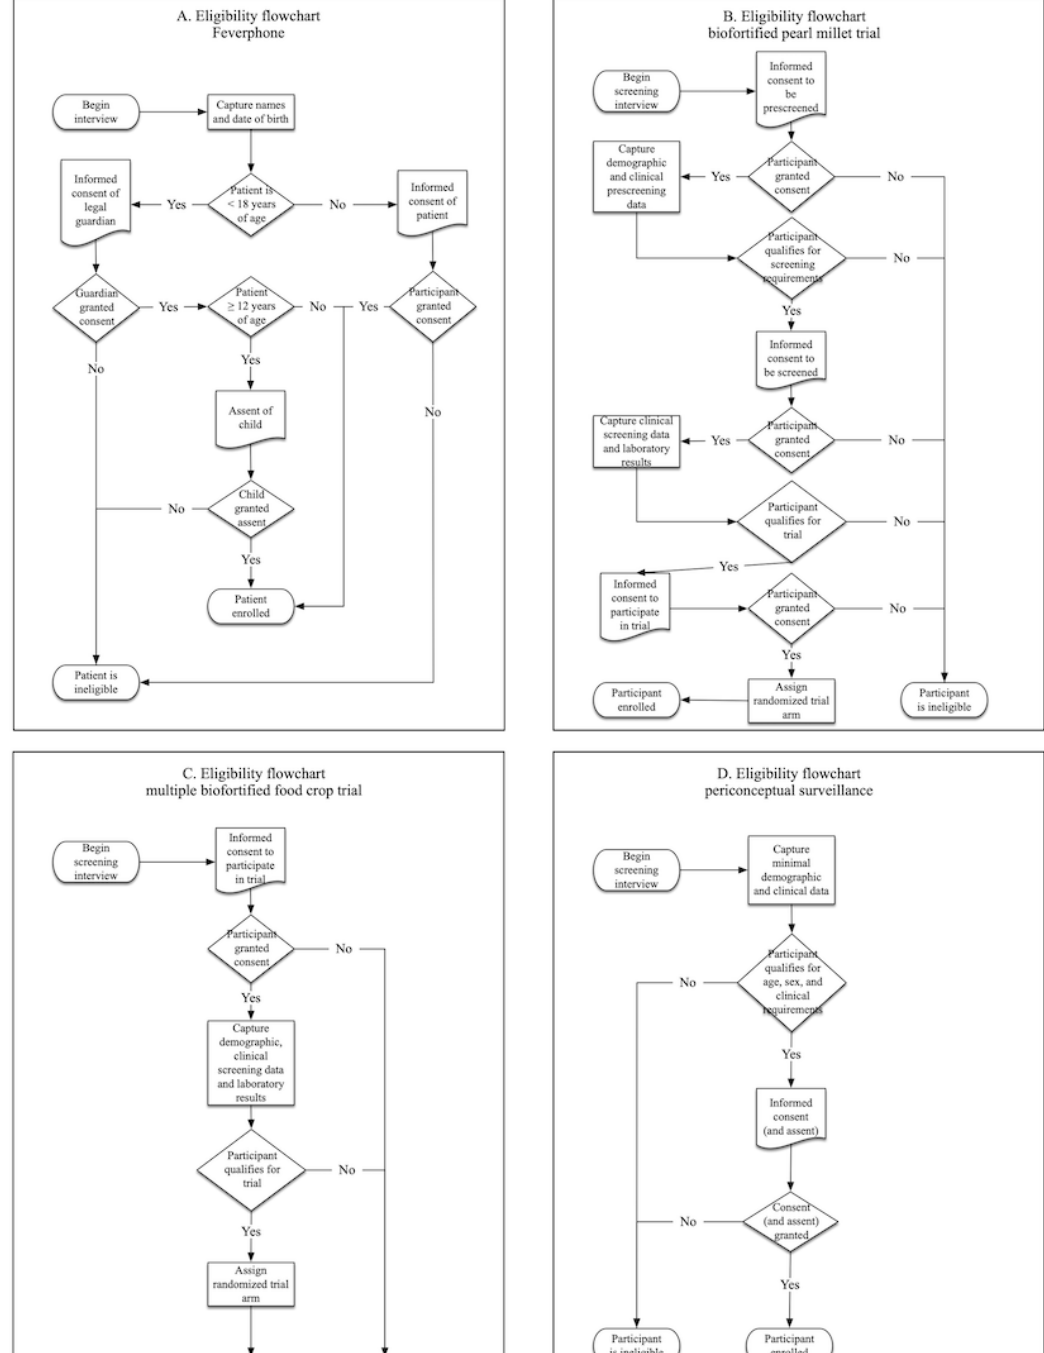
Figure 1. Eligibility protocol for (A) clinical setting: FeverPhone, Ecuador; (B) RCT, Mumbai; (C) RCT, South India; (D) surveillance study, South India. RCT: randomized controlled